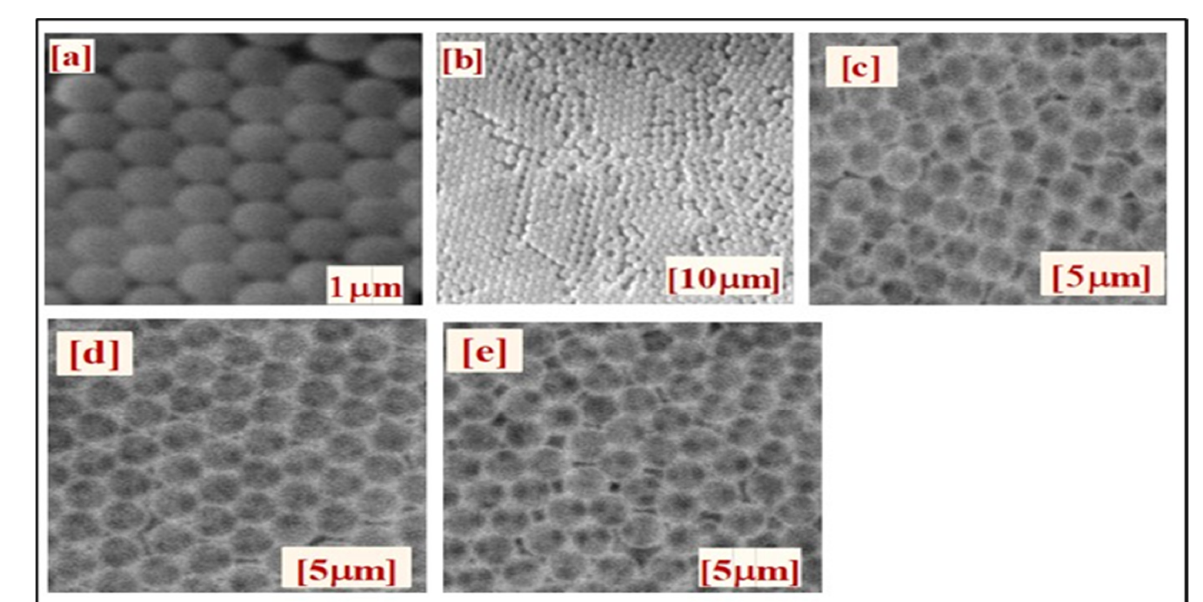
Figure 3. SEM images of PS opal: ( a ) and ( b ); pure TiO 2 IO: ( c ); Al 2 O 3 thermal ALD on IO: ( d ); and Al 2 O 3 plasma ALD on IO: ( e ).